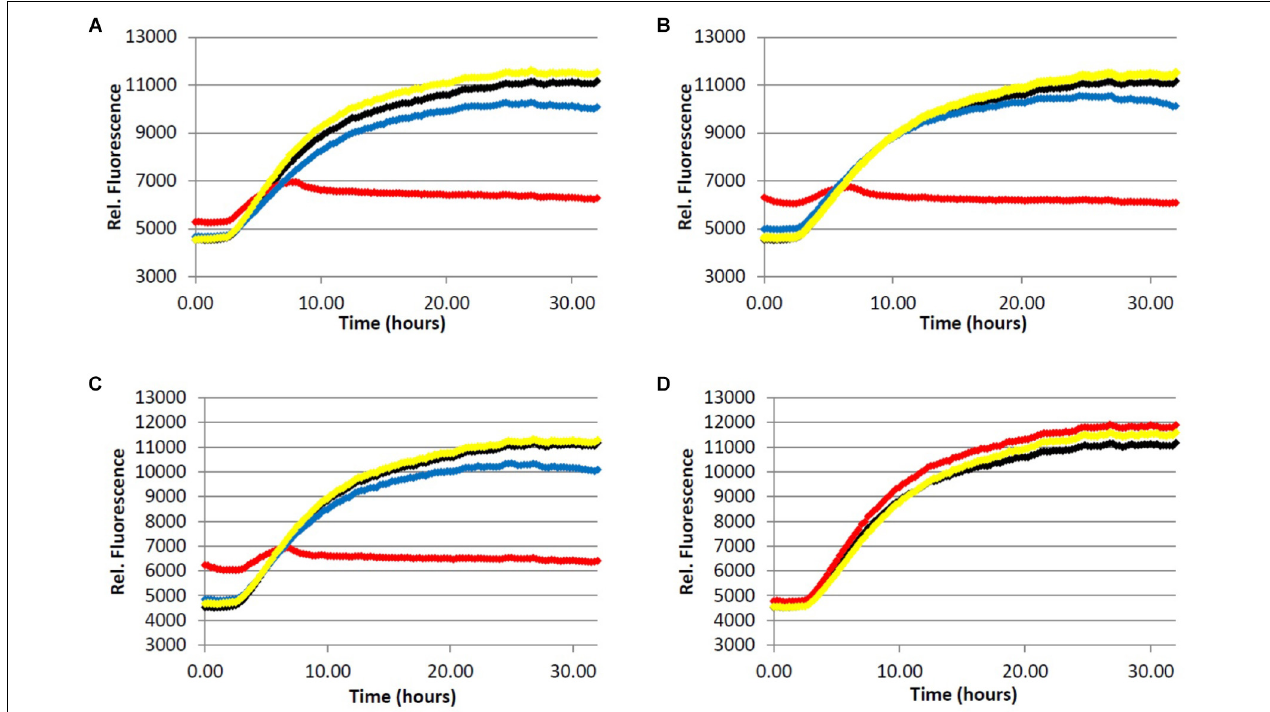
FIGURE 3 | Fibrillization of tau protein. 4.0 µ M tau in Tris buffer (50.0 mM, pH 7.4, 10.0 µ g/mL heparin, 1.0 mM dithiothreitol, 50.0 mM sodium azide) was incubated at 37.0 ◦ C in the presence of 5.0 µ M ThS and variable concentration of analyte. (red) = 200 µ g/mL, (blue) = 40.0 µ g/mL, (yellow) = 5.0 µ g/mL, (black) = 0.0 µ g/mL (vehicle control). (A) Light roast instant coffee extract. (B) Dark roast instant coffee extract. (C) Decaffeinated dark roast coffee extract. (D) Caffeine 1 .